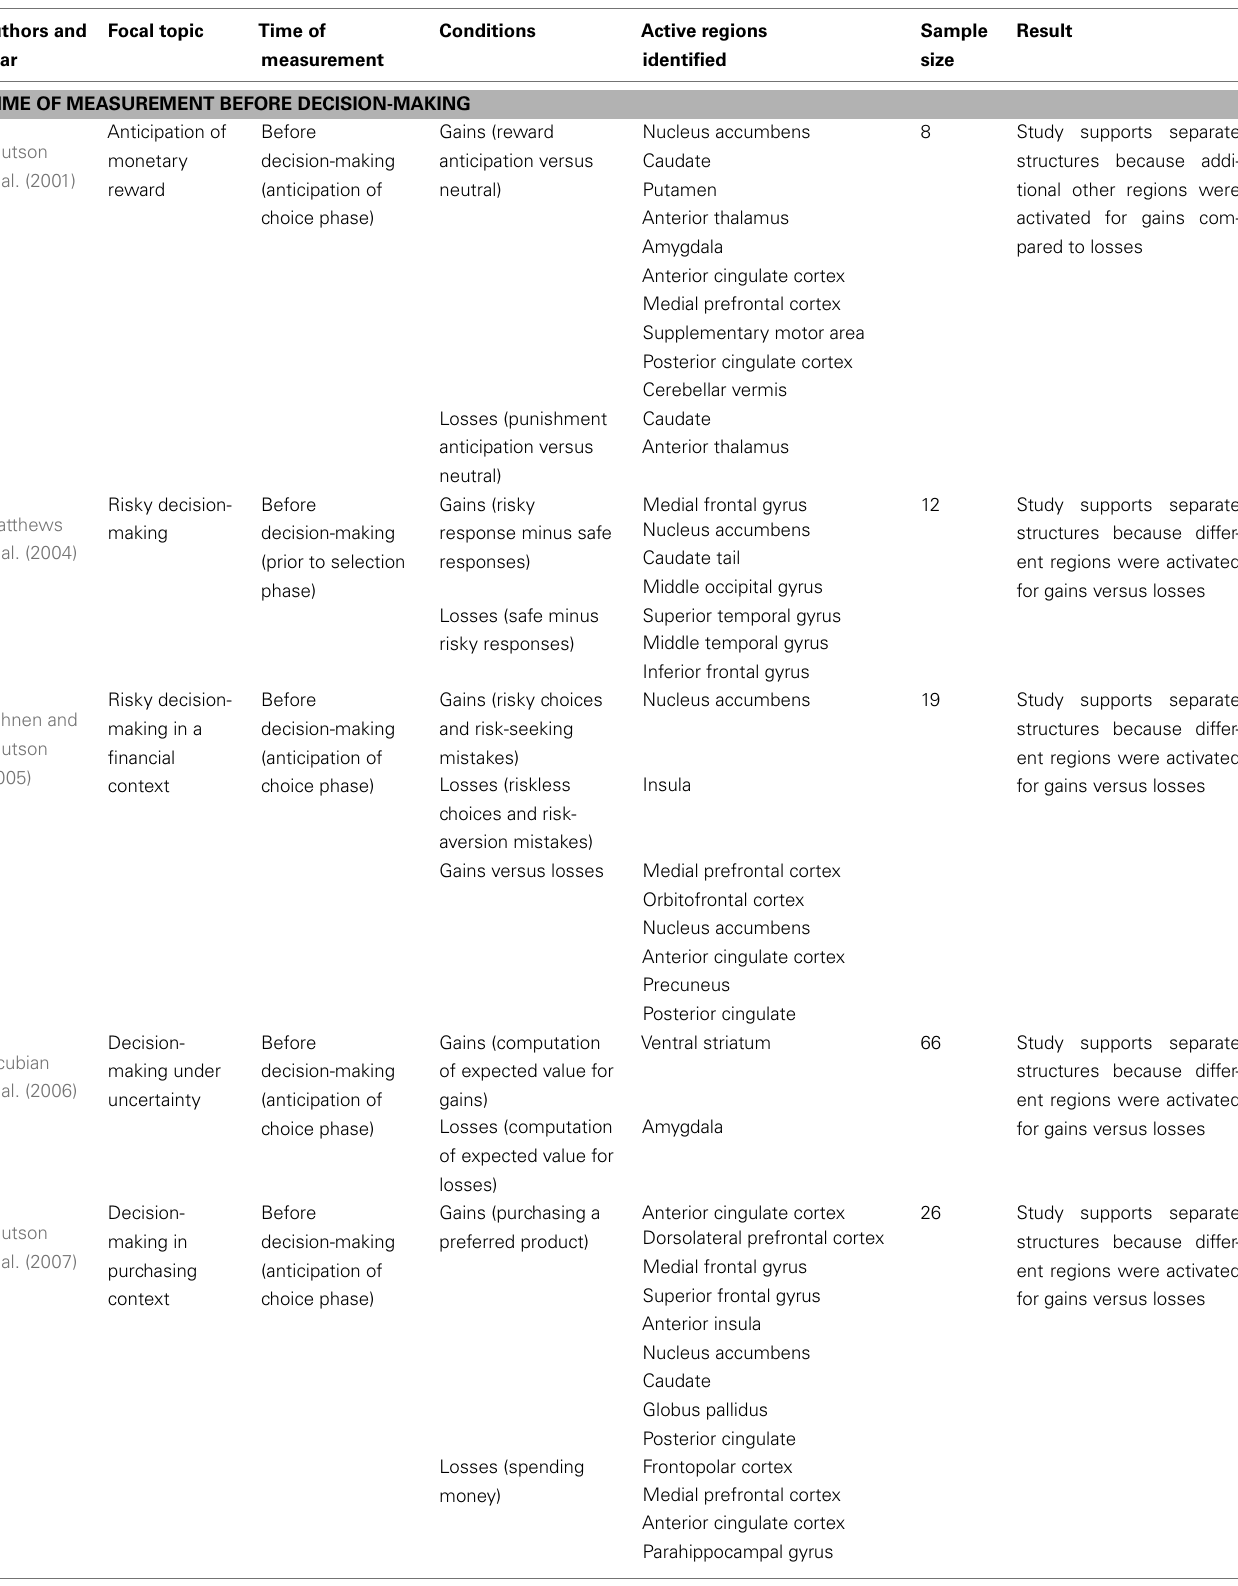
Table 1 | Functional magnetic resonance imaging studies of risk-taking for gains and losses. Authors